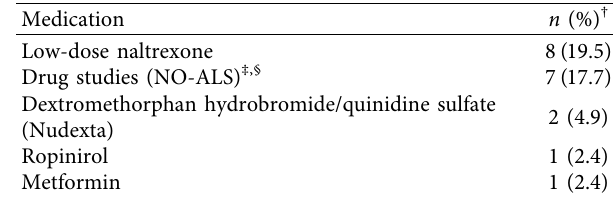
Table 1: Patients reporting off-label use of medications against ALS.